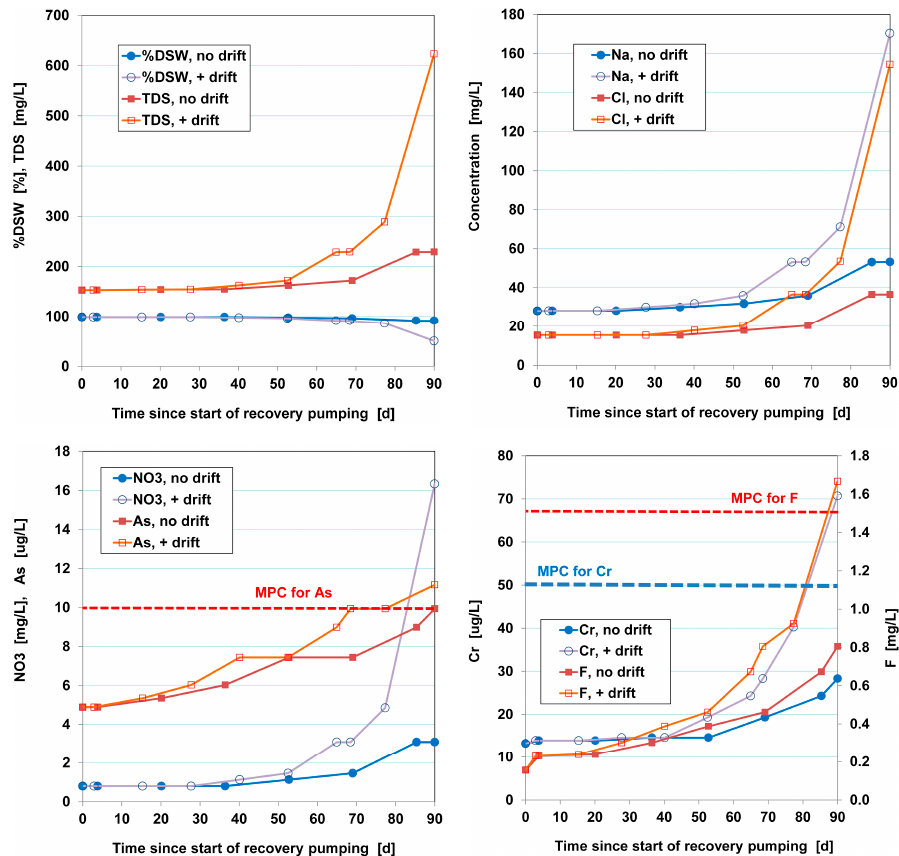
Figure 12. With EL calculated concentration trends of selected elements dissolved in groundwater that is recovered from the DSW basin infiltration system after 824 d of recharge, without bubble drift (no storage phase) and with bubble drift (with 10 years of standstill prior to recovery). MPC = Maximum Permissible Concentration by Abu Dhabi’s drinking water standard.